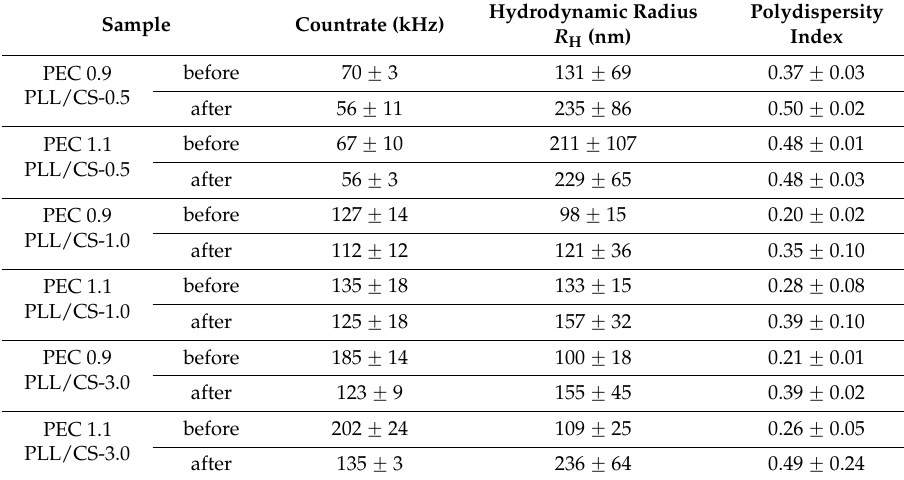
Table 2. DLS results of drug free PEC particles, comparison of DLS parameters of PEC dispersions before and after centrifugation